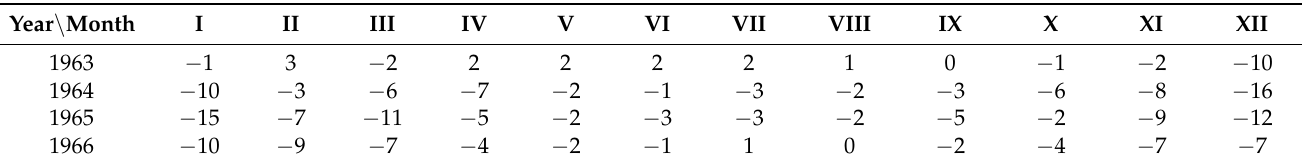
Table 6. Deviation (%) of direct radiation intensity from the long-term average over USSR territory. Data is taken from